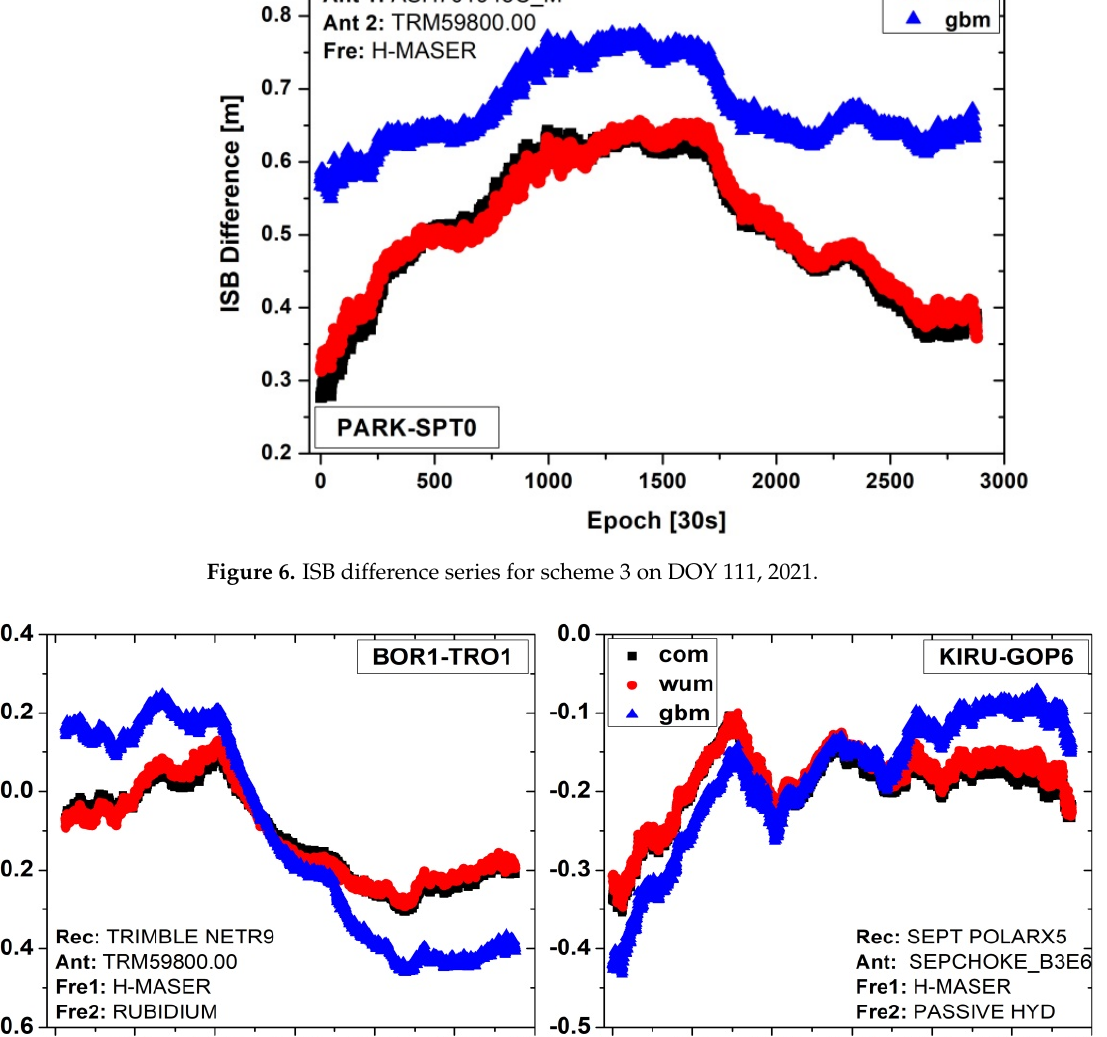
Figure 8. ISB difference series for scheme 5 on DOY 119, 2021.